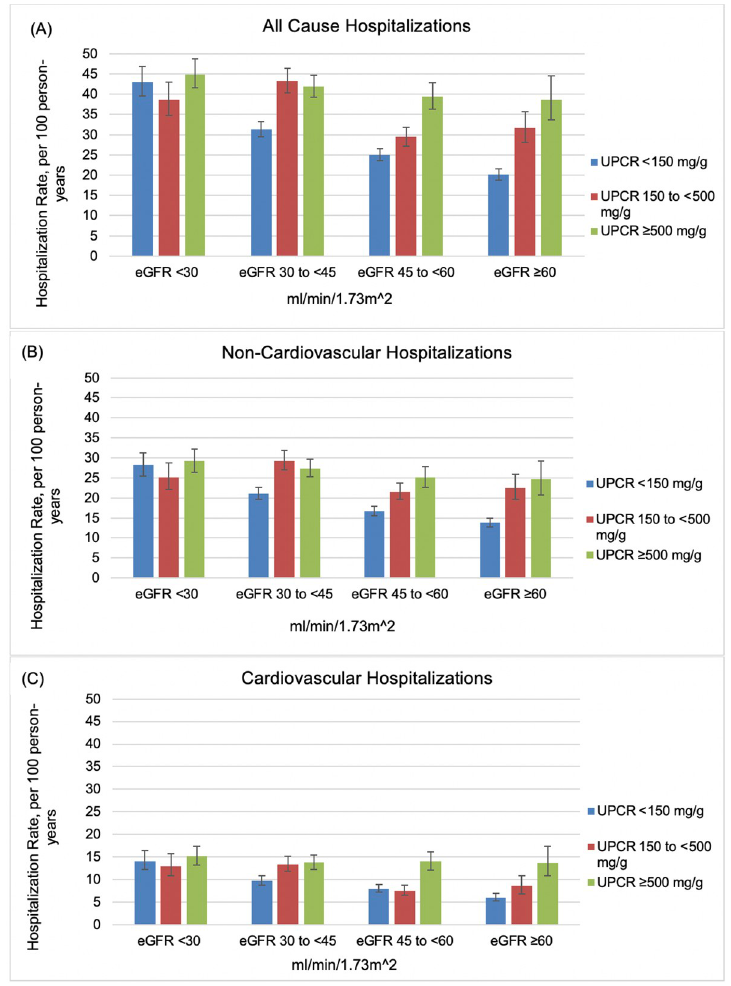
Fig 3. Adjusted rates of hospitalization for (A) all-causes, (B) non-cardiovascular, and (C) cardiovascular, by level of eGFR and proteinuria. Models adjusted for age, race, sex, clinical center, education, SBP, diabetes, UPCR, eGFR, and interaction between UCPR and eGFR. eGFR, estimated glomerular filtration rate; SBP, systolic blood pressure; UPCR, urine protein-to-creatinine